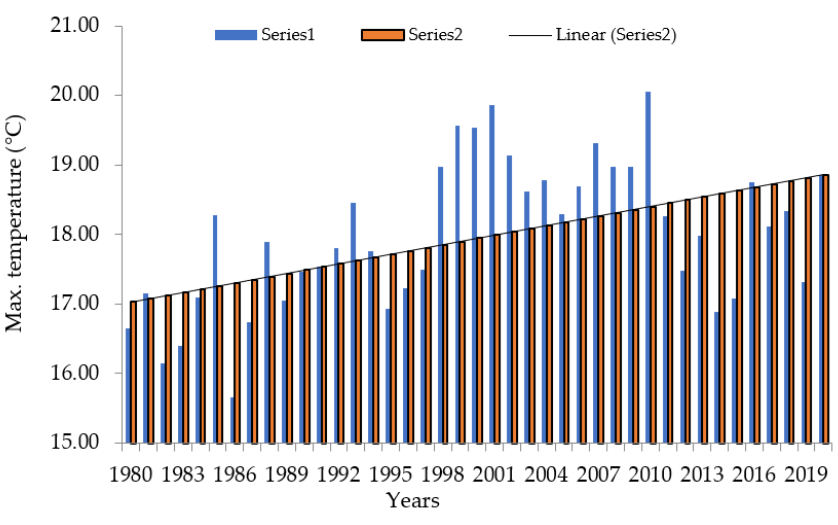
data (maximum and minimum temperatures and rainfall) from 1980 to 2020. It was found that maximum temperature with a slope of − 0.55 and R 2 value of 5.49 followed an increas- ing trend with respect to time series analysis (Figures 8A,B and Figure S7a) but was not significant and has increased to the range of 2.0 °C. Moreover, it was observed that mini- mum temperature followed the increasing trend over Kashmir valley but was not signifi- cant (slope = − 5.37) and increased to the extent of 1.10 °C from the last 41 years (Figures 8C,D and Figure S7b). However, precipitation with a slope of − 1.79 showed a non-signif- icant decreasing trend with respect to time series analysis from 1980 to 2020 in Kashmir valley (Figures 8E,F and Figure S7c).